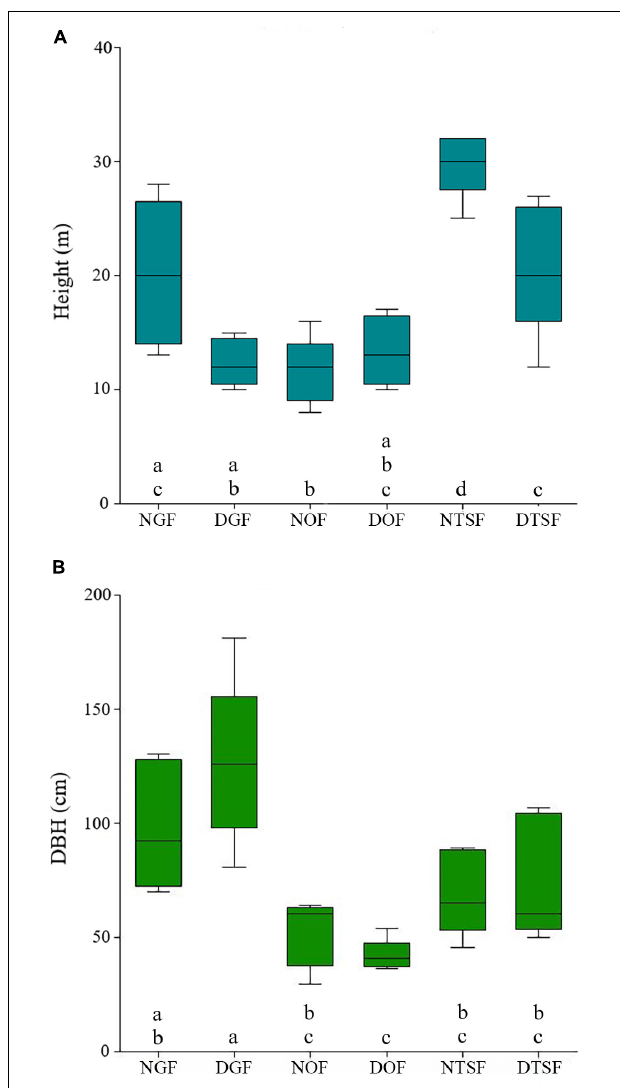
FIGURE 7 | Variation in the height (A) and diameter breast height (DBH) (B) of the phorophytes in each sampling site (NGF = natural gallery forest, DGF = disturbed gallery forest, NOF = natural oak forest, DOF = disturbed oak forest, NTSF = natural tropical sub-deciduous forest, DTSF = disturbed tropical sub-deciduous forest). Sampling sites that do not have the same letter are significantly